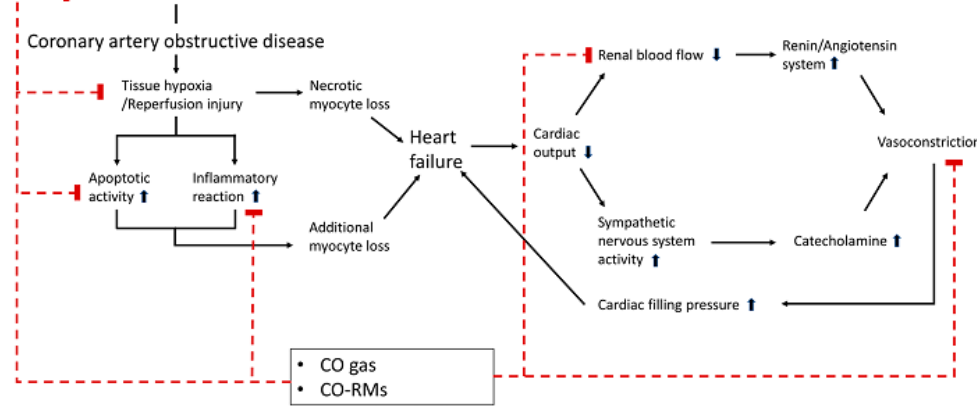
Figure 2. Mechanisms of the favorable effects of carbon monoxide in cardiovascular diseases. Carbon monoxide (CO) can exhibit inhibitory effects on the initiation and progression of cardiovascular disease. (1) CO could suppress the formation of atherosclerosis in the coronary artery and prevent the initiation of coronary artery obstructive disease by the inhibition of the proliferation of smooth muscle cells in the coronary artery. (2) Through anti-apoptotic and anti-inflammatory properties, CO could diminish the loss of myocyte following acute coronary syndrome. (3) The vasodilatory effects of CO can prevent the vicious cycle of heart failure by inhibiting vasoconstriction as a result of the activated renin/angiotensin system and the sympathetic nervous system to compensate for low cardiac output and systemic hypo-perfusion in heart failure. The upward pointing arrow and the downward pointing arrow mean activation and inhibition for each pathway,